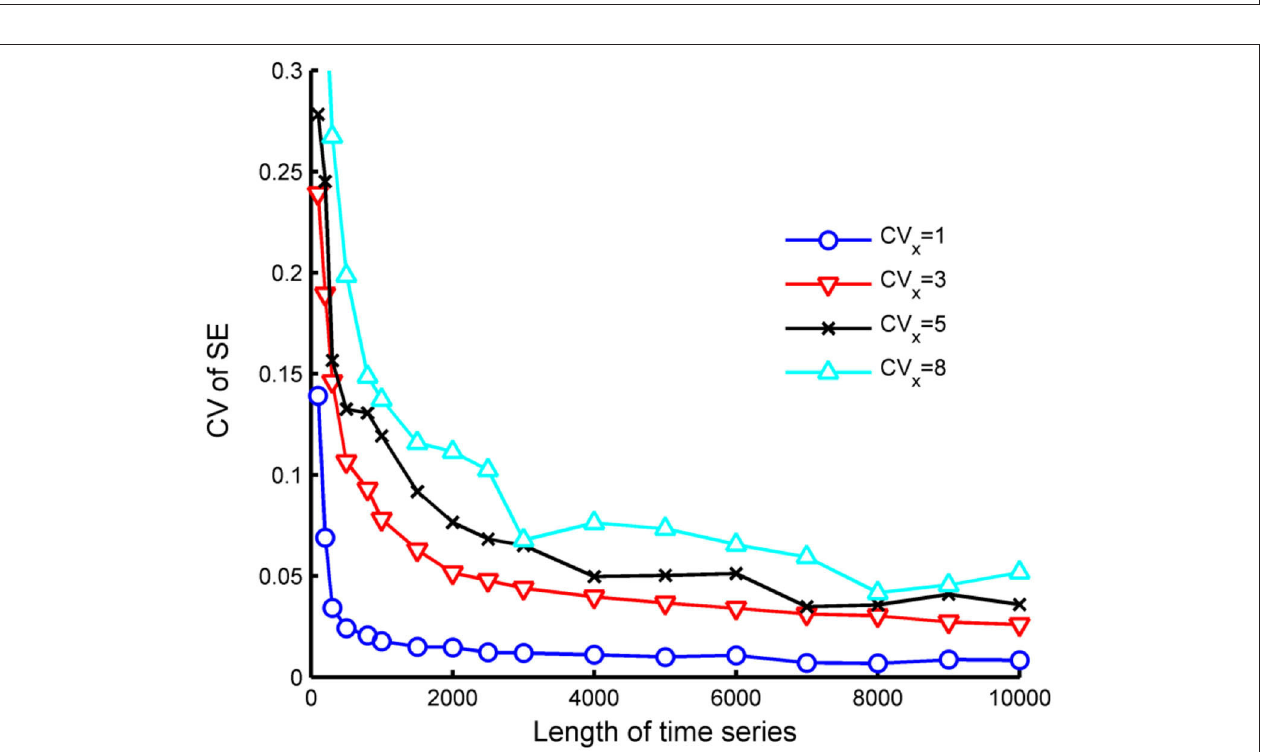
FIGURE 6 | Variation of CV of SE with respect to length and CV X of the time series (m